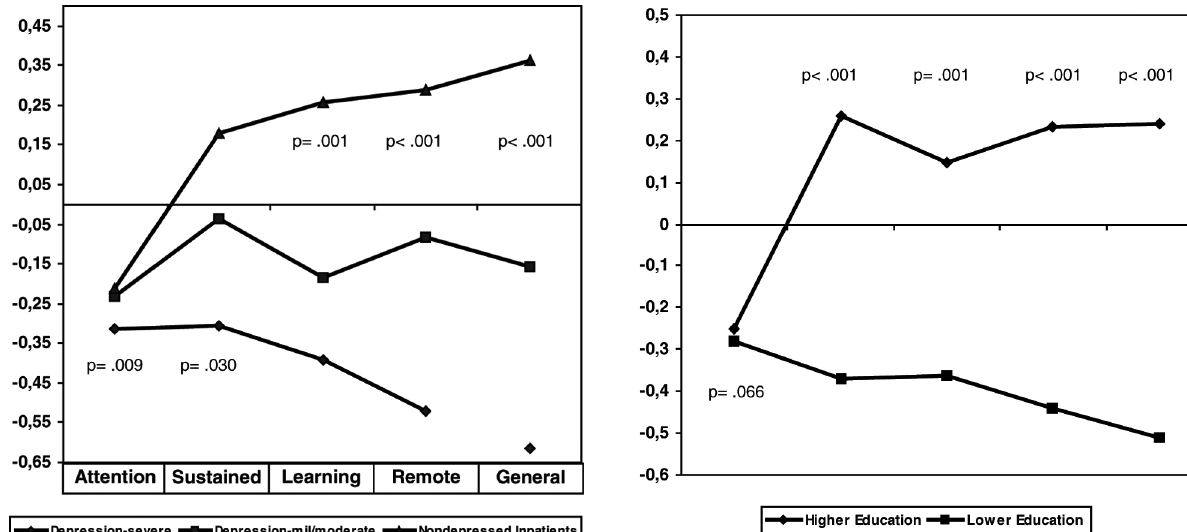
Figure 1. Domain z-scores for the three groups (severe depres- sion, mild/moderate depression and medical inpatients).